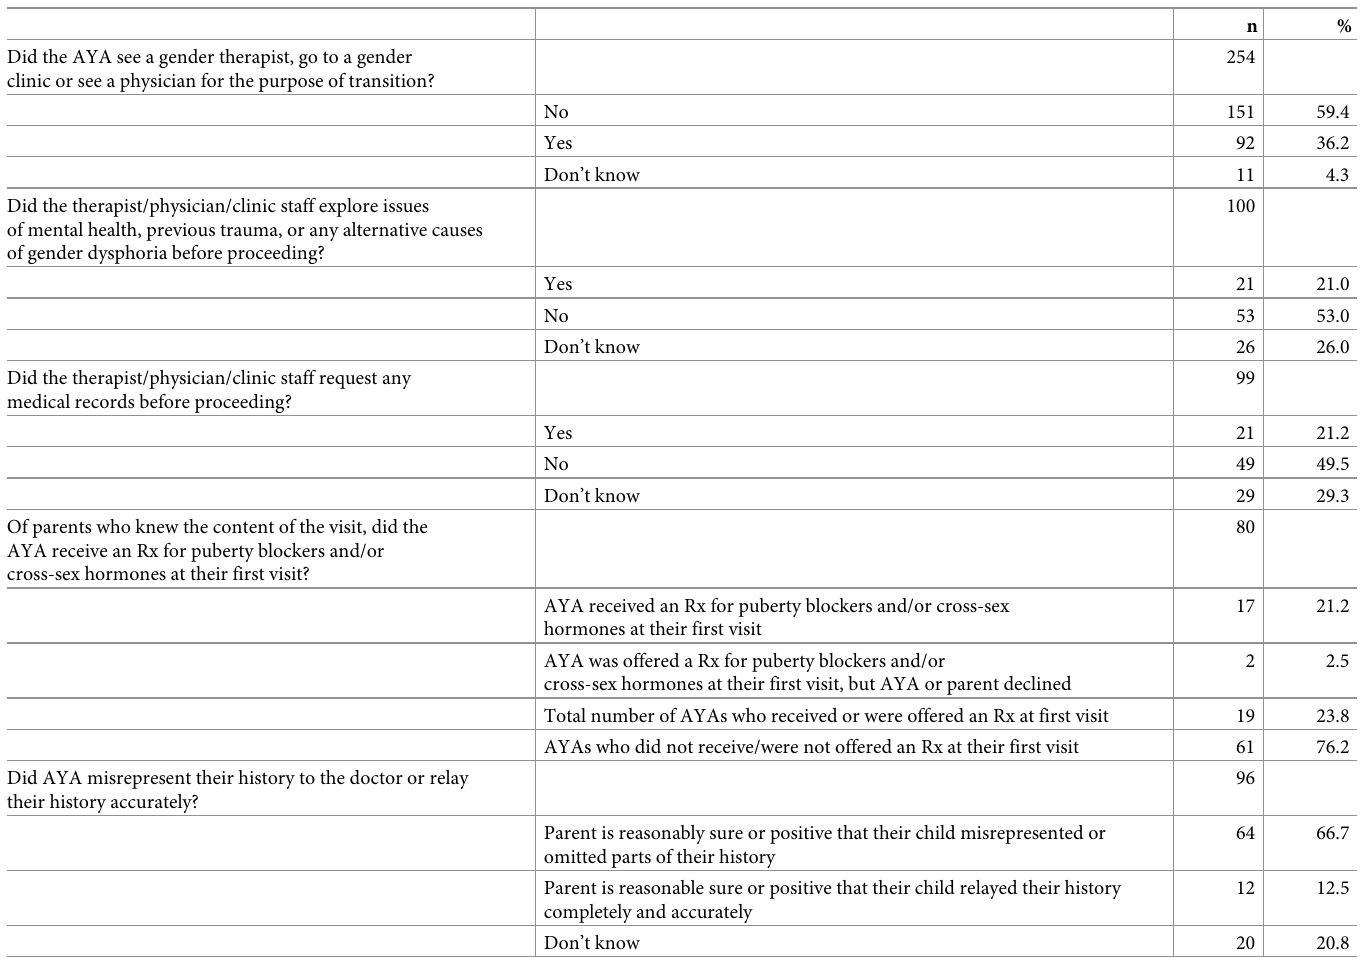
Table 11. Interactions with clinicians.